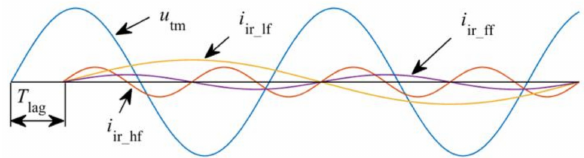
Figure 2. Injection pattern of irregular currents. u tm : terminal voltage; i ir_hf : high frequency current; i ir_lf : low frequency current; i ir_ ff : negative sequence fundamental frequency